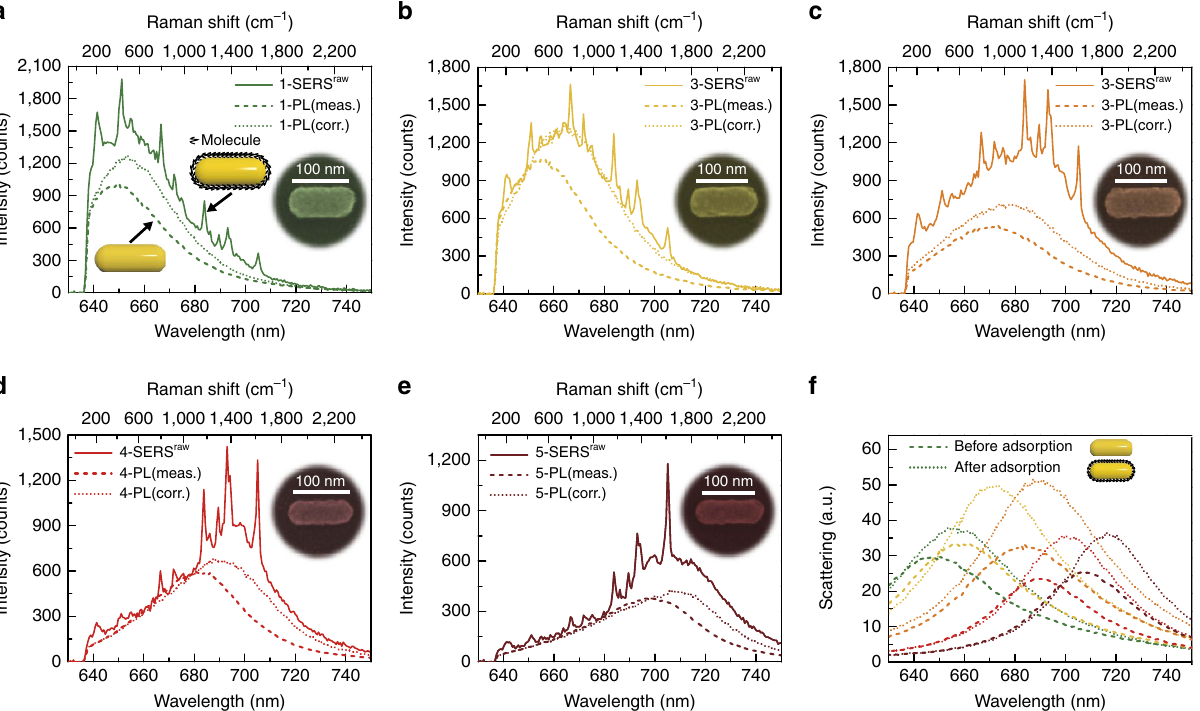
Figure 3 | Quantitative correlation of the SERS background and PL for single gold nanorods. ( a – e ) Measured PL signal, PL(meas.) (dashed lines), of five gold nanorods with different aspect ratio in the absence of molecules and the corresponding SERS raw spectra (which includes a spectrally broad background) after adsorption of the MGTIC molecules (solid lines). All measurements were performed under 633nm laser illumination. The dotted lines, PL(corr.), correspond to the PL after applying the correction described by equation (3), which accounts for the influence of the molecules on the plasmonic resonance. The insets are the SEM images of the five nanorods in pseudo color, which show an increased aspect ratio from a , e . Scale bar, 100nm. ( f ) Scattering spectra of the five gold nanorods measured before (dashed lines) and after (dotted lines) adsorption of the MGITC